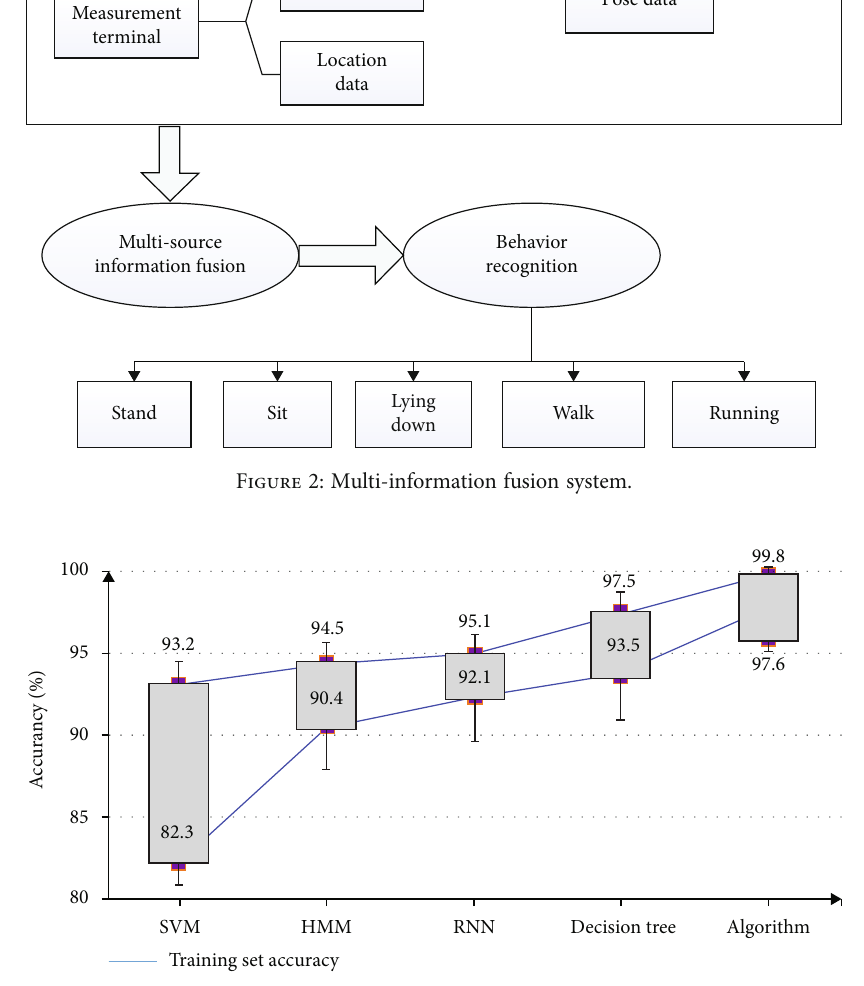
Figure 3: Comparative analysis of recognition rates of di ff erent algorithms.